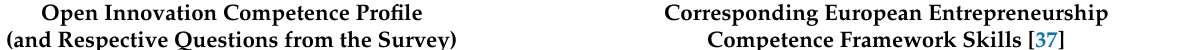
Table 1. OpenInnovation CompetenceProfileand corresponding skillsfromEuropeanEntrepreneurship CompetenceFramework. Open Innovation Competence Profile (and Respective Questions from the